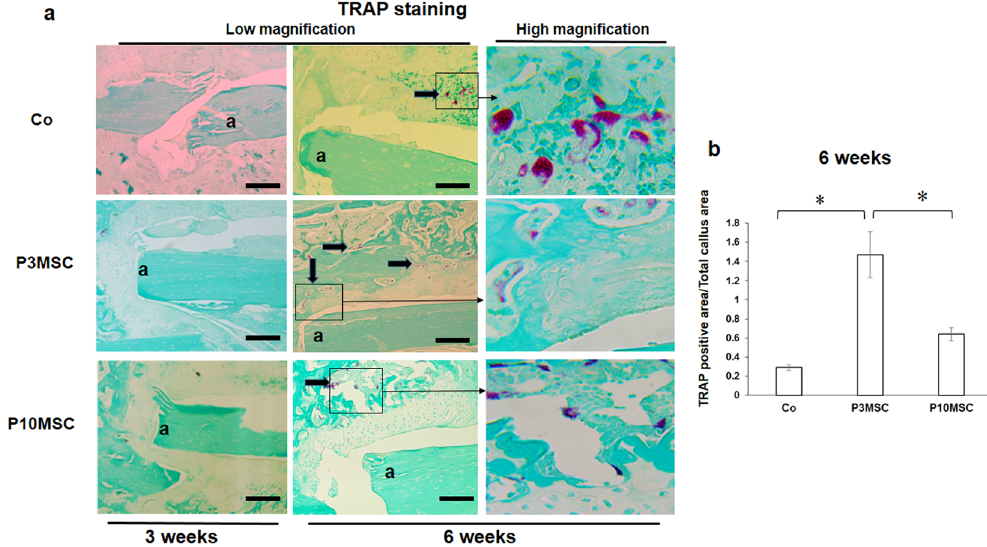
Figure 7. Enhanced osteoclast activity and callus remodeling in young P3 MSC sheet wrapped allografts. ( a ) Representative images of TRAP staining in new callus at 3 weeks (left) and 6 weeks (right) post-surgery with high magnification. ( b ) Quantification of the percent ratio of TRAP staining positive osteoclast area vs total callus area (n = 6) at 6 weeks post-surgery. Allograft is labeled as: a. Scale bar, 400 um. * P <